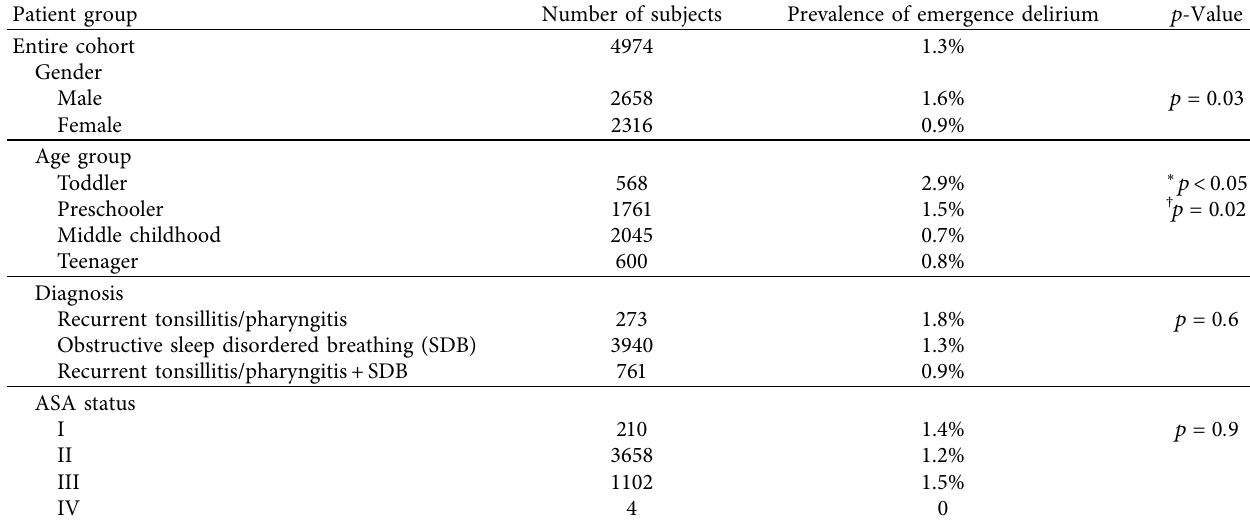
Table 1: Characteristics of study patients.